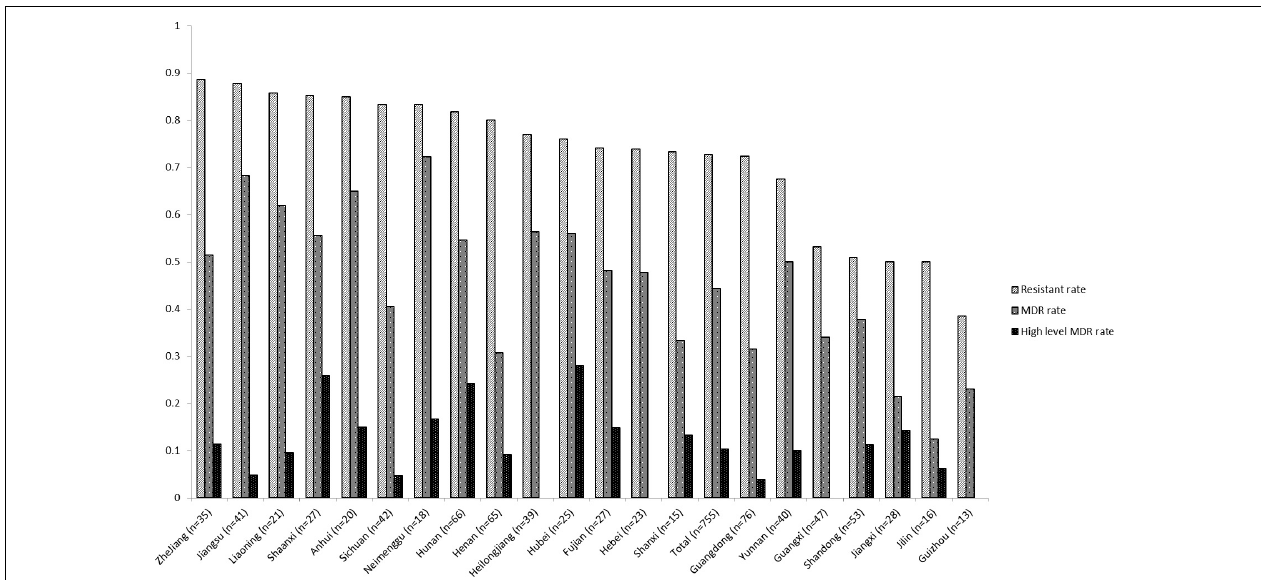
FIGURE 1 | Antimicrobial resistance of foodborne Salmonella isolates recovered from different provinces in mainland China, 2016. [Multi-drug resistant (MDR), resistant to three or more classes of antimicrobial